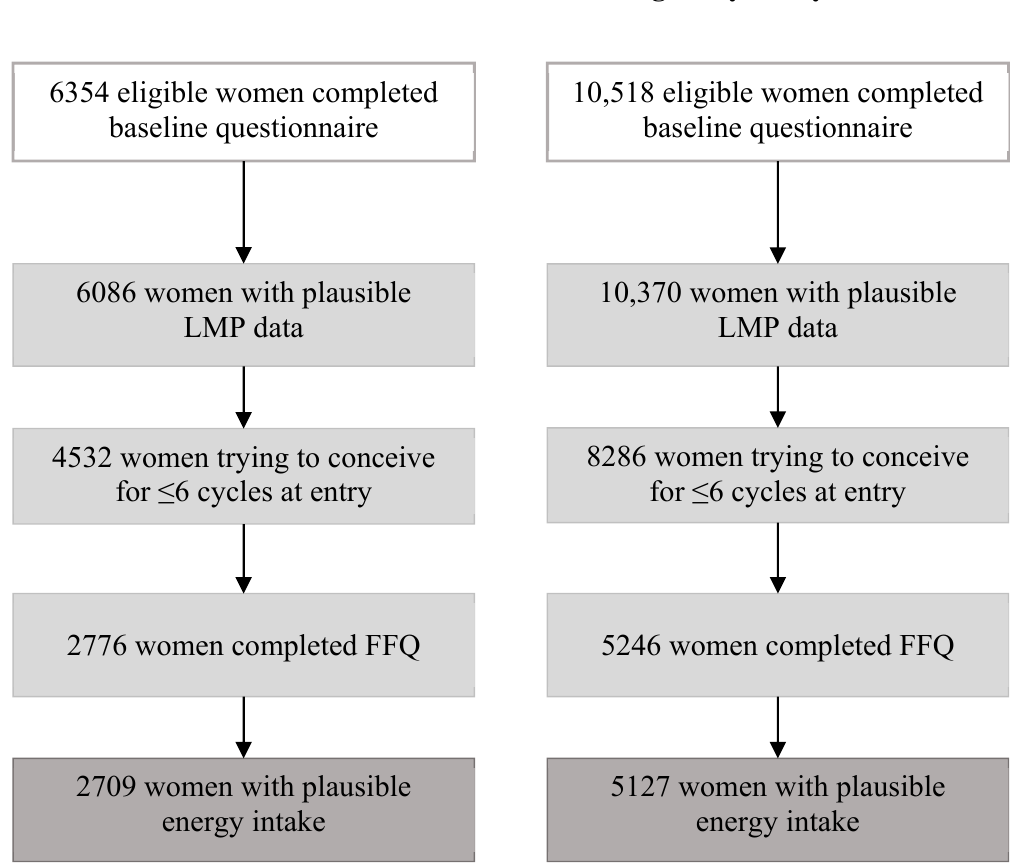
Figure 1. Flowchart of participant exclusions, 2013–2018 (Snart Foraeldre) and 2013–2019 (PRESTO).